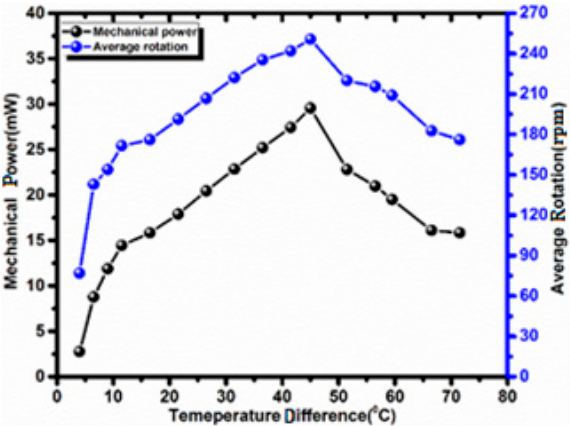
Figure 18. Mechanical power of the system delivered by the thermomagnetic engine at various temperature differences between hot and cold water jets.